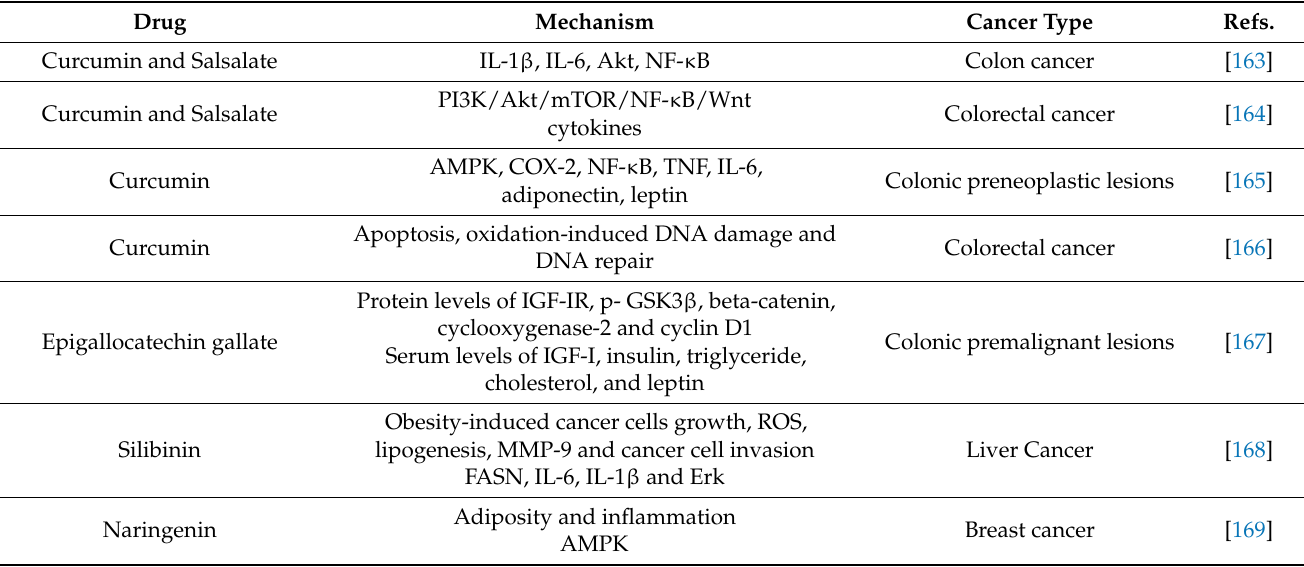
Table 4. Antioxidants preventing cancer associated with obesity and systemic